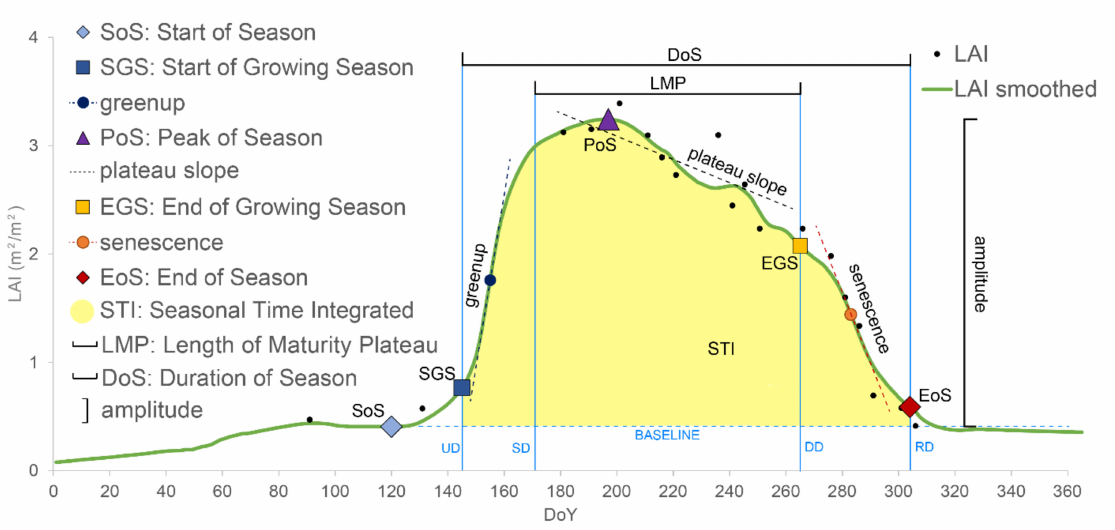
Figure 3. Smoothed LAI time series with estimated phenological metrics.